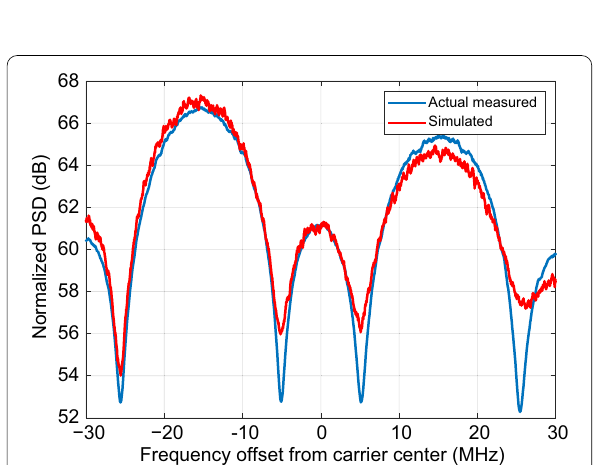
Fig. 11 Power spectrum of BDS-3 GEO-1 B2